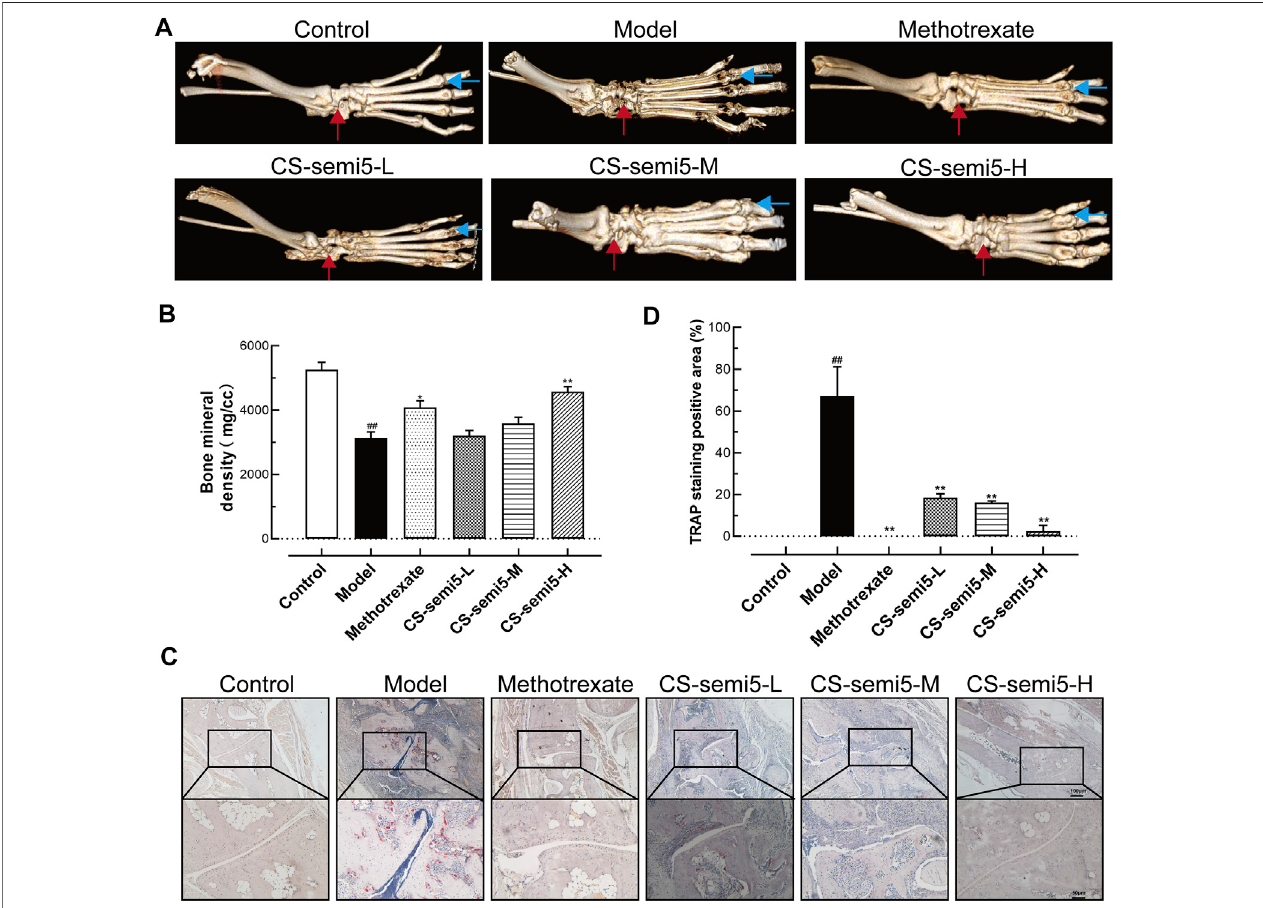
FIGURE 4 | CS-semi5 attenuates bone destruction and bone marrow erosion in CIA mice. (A) Representative micro-CT 3D images of hind paws as recorded on day 49. Red arrows indicate the ankle joint structure, and blue arrows indicate the joint space. (B) Bone marrow erosion was measured via digital quanti fi cation of bone mineraldensity. (C) OsteoclastsoftheanklejointswerestainedwithTRAP.Redareasindicateosteoclasts.Originalmagni fi cationwas40 × ,and100 × magni fi cationwas usedinhigh-powerviews.Barrespectivelyindicates100and50 μ m. (D) TRAP-positivestainingwasmeasuredbydigitalquanti fi cation. n (cid:1) 7. ## p < 0.01compared with Control group; * p < 0.05 and ** p < 0.01 compared with Model